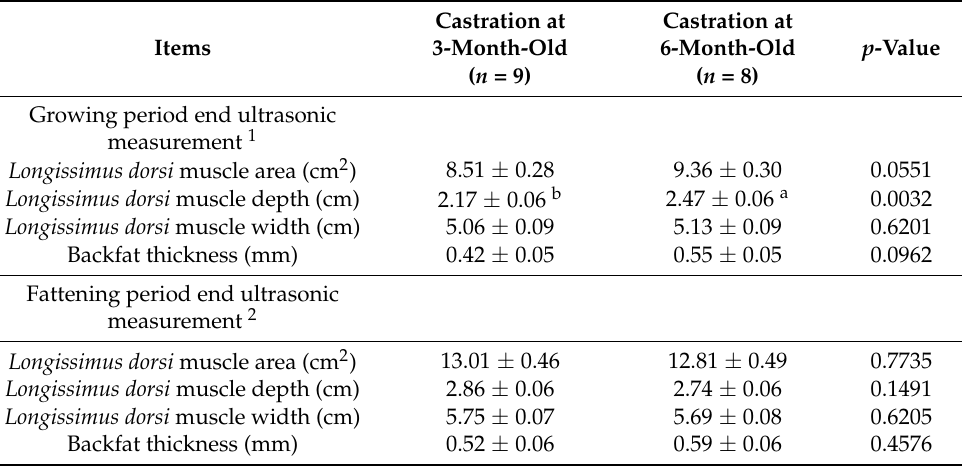
Table 3. Effects of castration at different ages on longissimus dorsi muscle in Nubian crossbred male goats at the end of the growing and fattening period (LSM ±